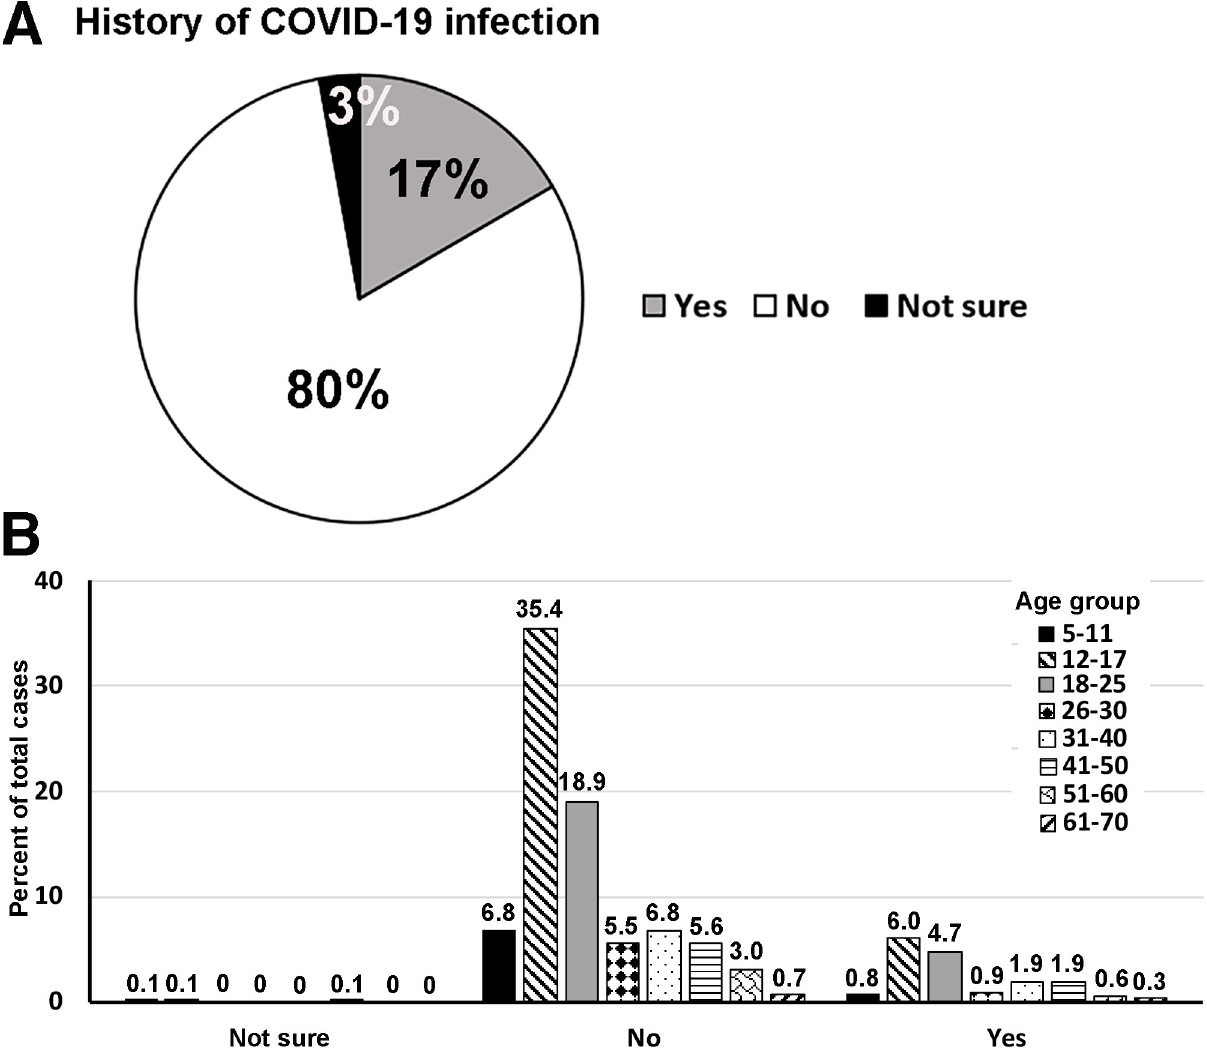
Fig 3. Distribution of participants by a history of COVID-19 infection. Most participants did not have COVID-19 infection, and only 17% of total participants had COVID-19 infection (A). The history of COVID-19 infection by age group was shown, and the group of 12–17 years old had the most number of participants with a history of COVID-19 infection